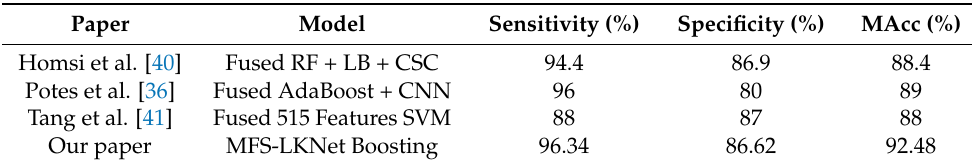
Table 3. Comparison of fusion